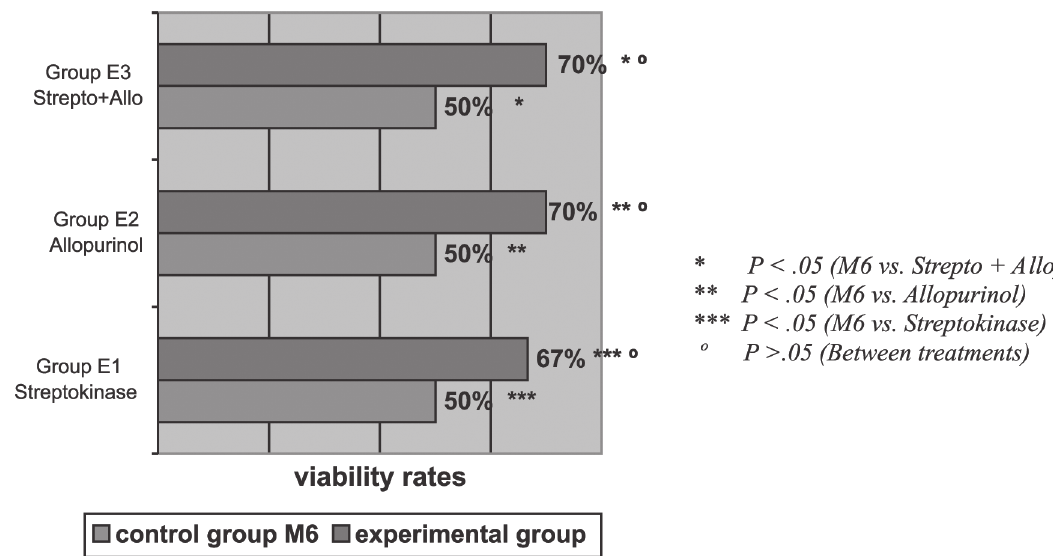
Figure 4 - Experimental groups. Streptokinase and Allopurinol viability rates. The combination produced no further improvement.